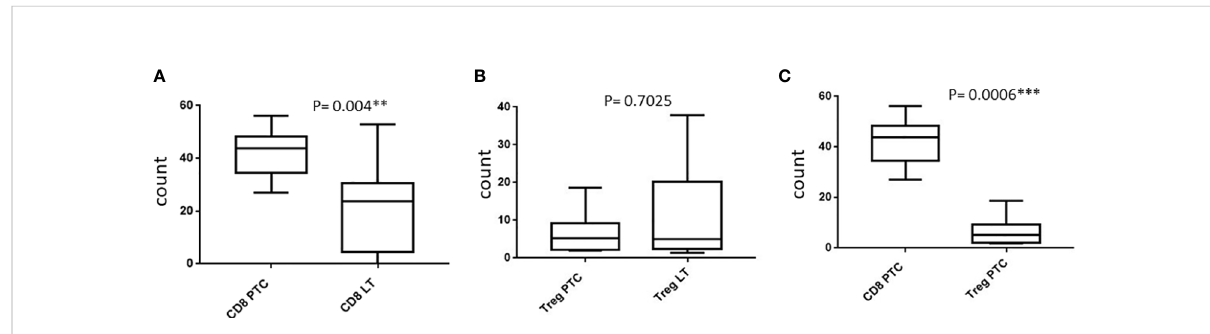
FIGURE 5 (A – C) Relative protein expression in fl ow cytometry.